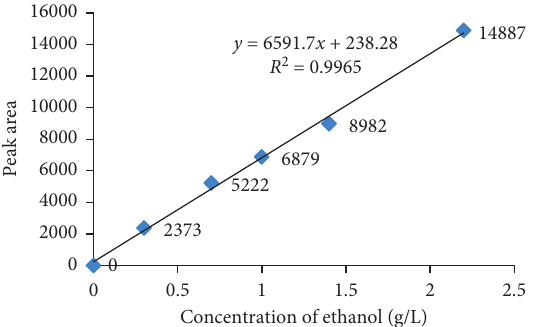
Figure 6: The linear plot between peak area in chromatogram and concentration of ethanol.